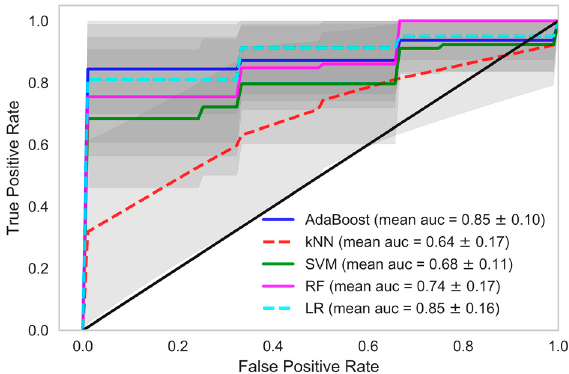
Figure 4. Receiver Operating Characteristics plot showing mean area under curve of all the classifiers of Model 3 when all HD sessions were considered.